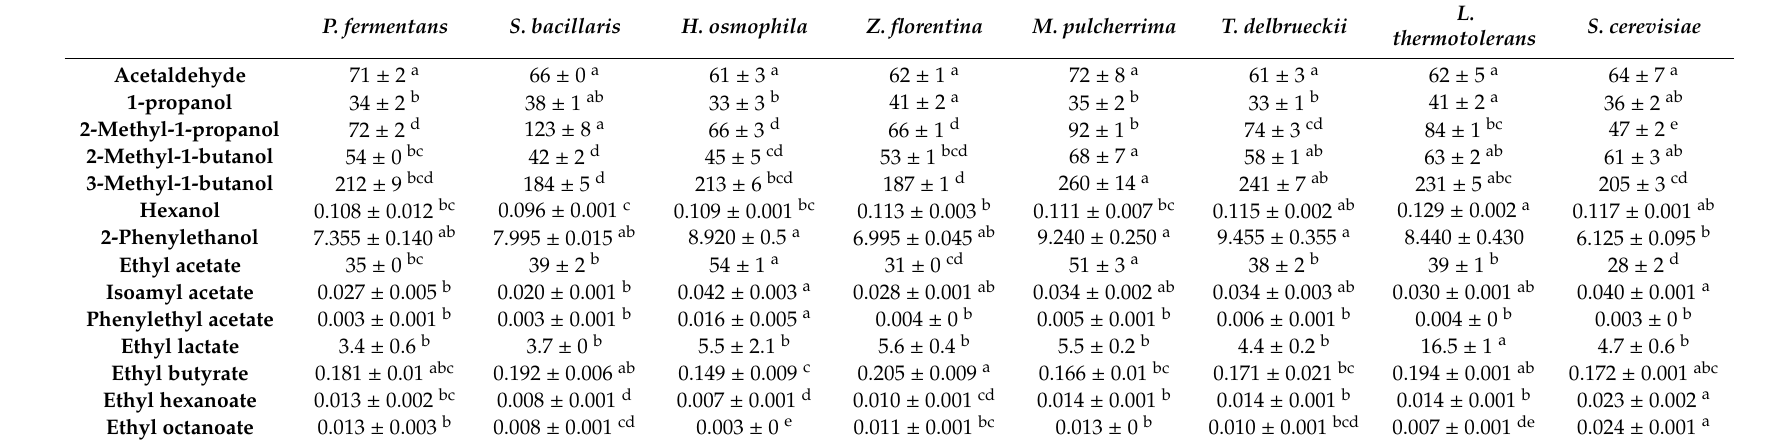
Table 3. Volatile compounds (mg / L) of wines four months after